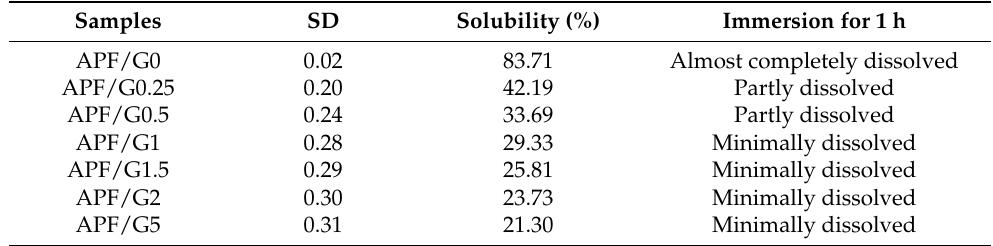
Figure 2. Swollen degree (SD) and solubility of cross-linking amylose/PVA blend films with different glutaraldehyde concentrations. Table 2. Swelling degree and solubility of amylose/PVA blend films in DMSO.